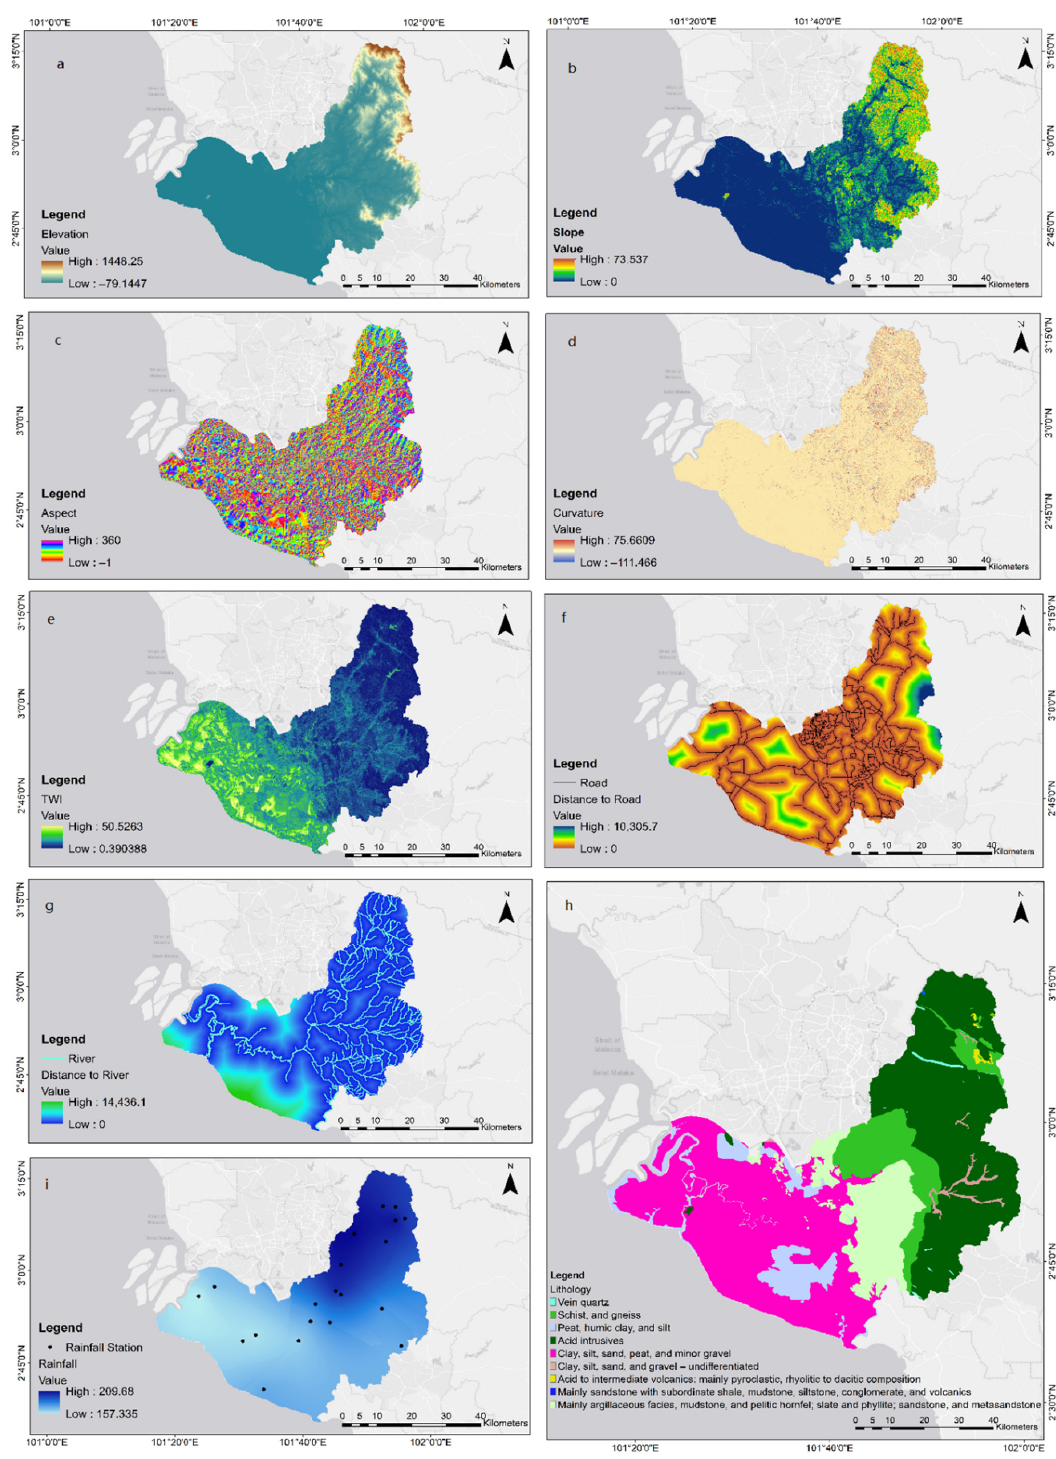
Figure 4. Landslide conditioning factors: ( a ) Elevation, ( b ) Slope, ( c ) Aspect, ( d ) Curvature, ( e ) TWI, ( f ) Distance to road, ( g ) Distance to river, ( h ) Lithology, and ( i ) Rainfall. (Spatial resolution for all landslide condition factors is 5 m × 5 m).